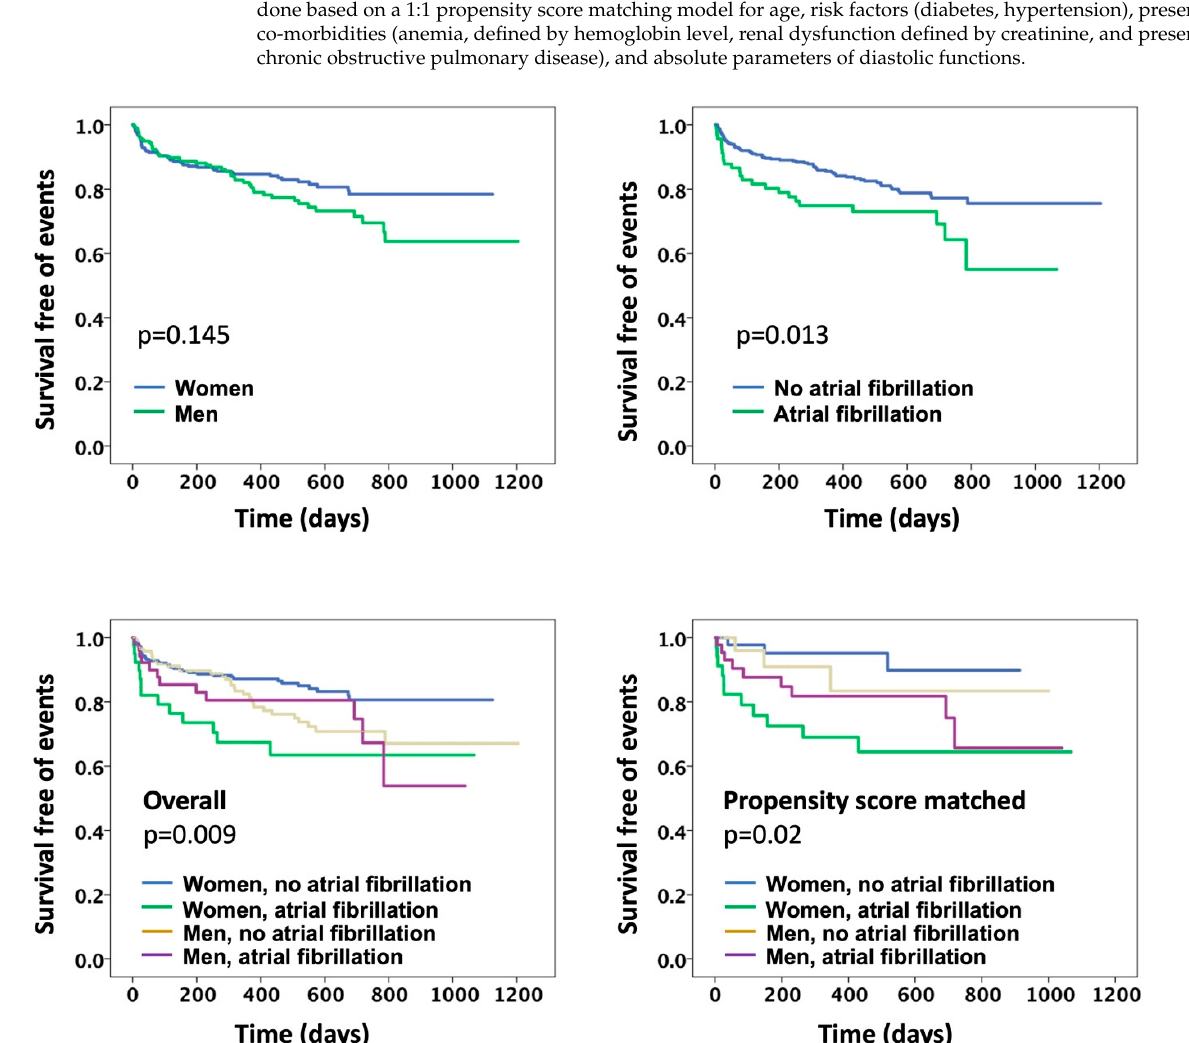
Figure 1. Kaplan-Meir survival curves for composite outcomes in the study. The Upper left panel shows the comparison between men and women, showing no significant difference. The upper right panel shows the comparison between patients with and without atrial fibrillation (AF), showing an increased risk in patients with AF. The lower right panel shows the comparison of subgroups clas- sified based on sex and presence of AF showing women with AF to be the highest risk category. The lower left panel shows the comparison of subgroups classified based on sex and presence of AF after 1:1 propensity score matching for co-variates showing women with AF to persist as the highest risk category. Table 3. Cox regression analysis for the prediction of outcomes. Death